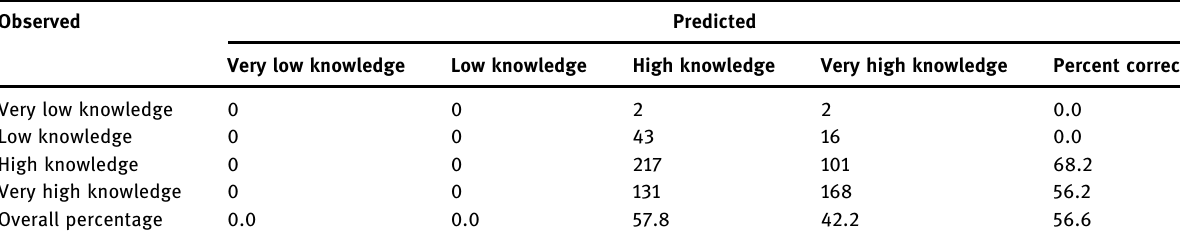
Table 6: Model prediction capacity